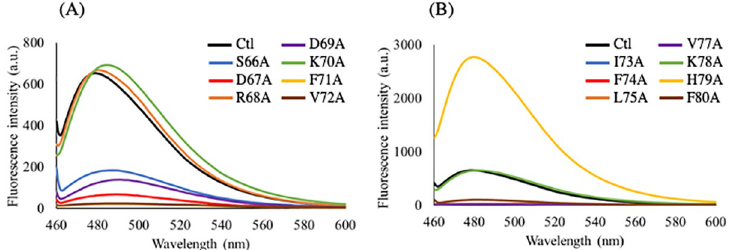
Fig 5. Emission spectra of the Thioflavin T (ThT) solution in the presence of the alanine substituents of α A66–80 peptides. Black lines show the emission spectrum of the ThT solution in the presence of normal α A66–80 (L- isoAsp76: Ctl). (A) Blue, red, orange, purple, green, yellow, and brown lines show the emission spectra of the ThT solution in the presence of S66A, D67A, R68A, D69A, K70A, F71A, and V72A substituents, respectively. (B) Blue, red, orange, purple, green, yellow, and brown lines show the emission spectra of the ThT solution in the presence of I73A, F74A, L75A, V77A, K78A, H79A, and F80A substituents, respectively. Each spectrum represents an average of five